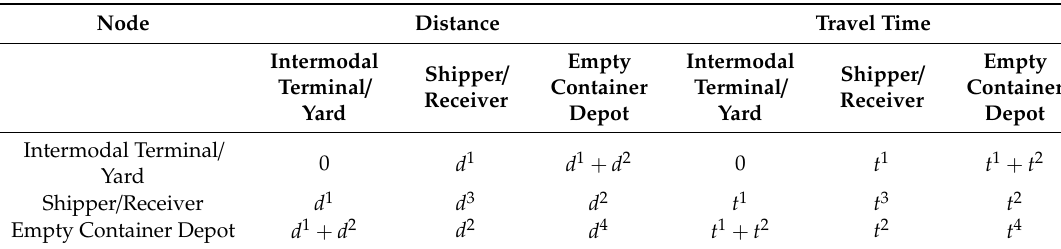
Table 2. Distance and travel time between the nodes.